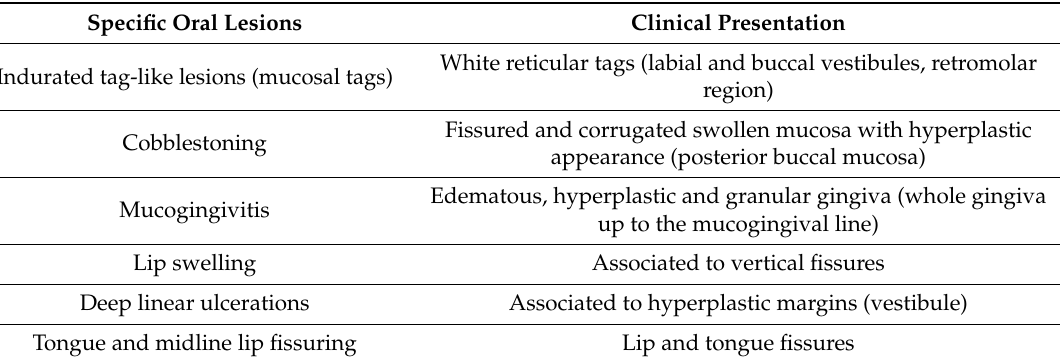
Table 2. Clinical characteristics of specific oral lesions in